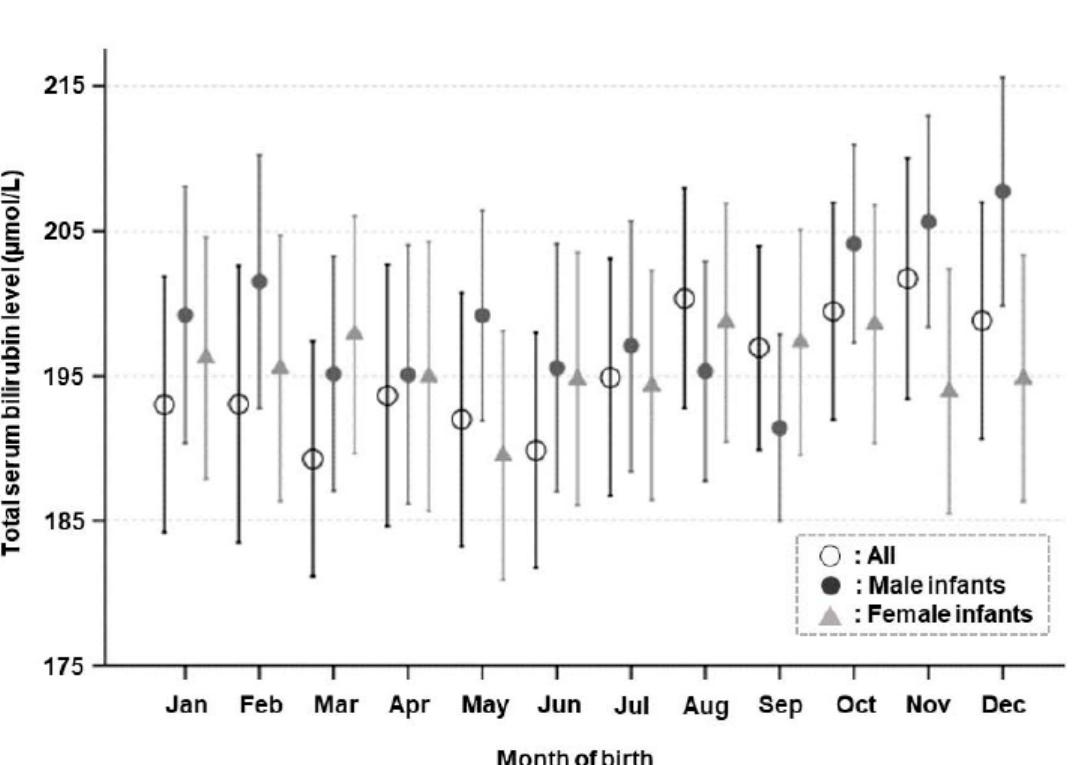
Figure 2. Serum bilirubin levels by the month of birth. Mean and 95% confidence interval for monthly total serum bilirubin level in healthy term neonates at four days after